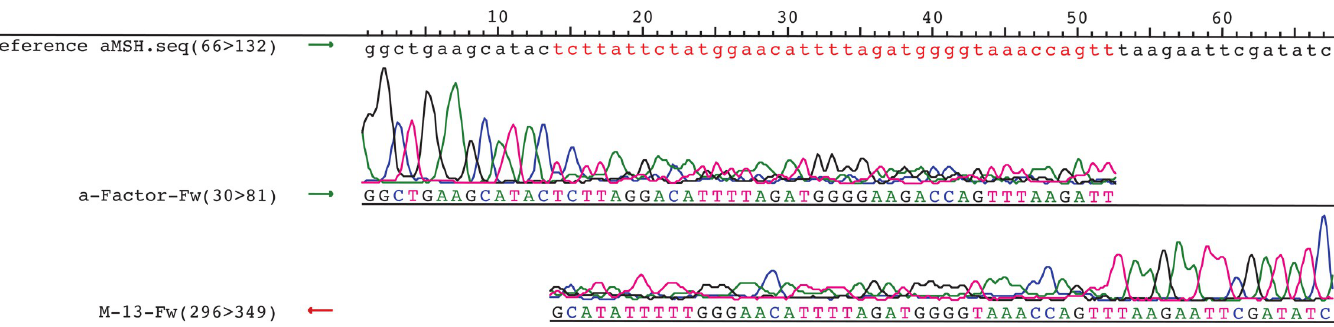
Fig 5. Assembling whole plasmid amplification (WPA) Sanger sequencing capillary electrophoresis chromatograms. Sequencing was performed using an a-Factor- Fw primer for forward strand sequencing and an M13-Fw primer for reverse strand sequencing. The fragment containing the sequence template ( α -MSH (red font)) was used as a reference for this